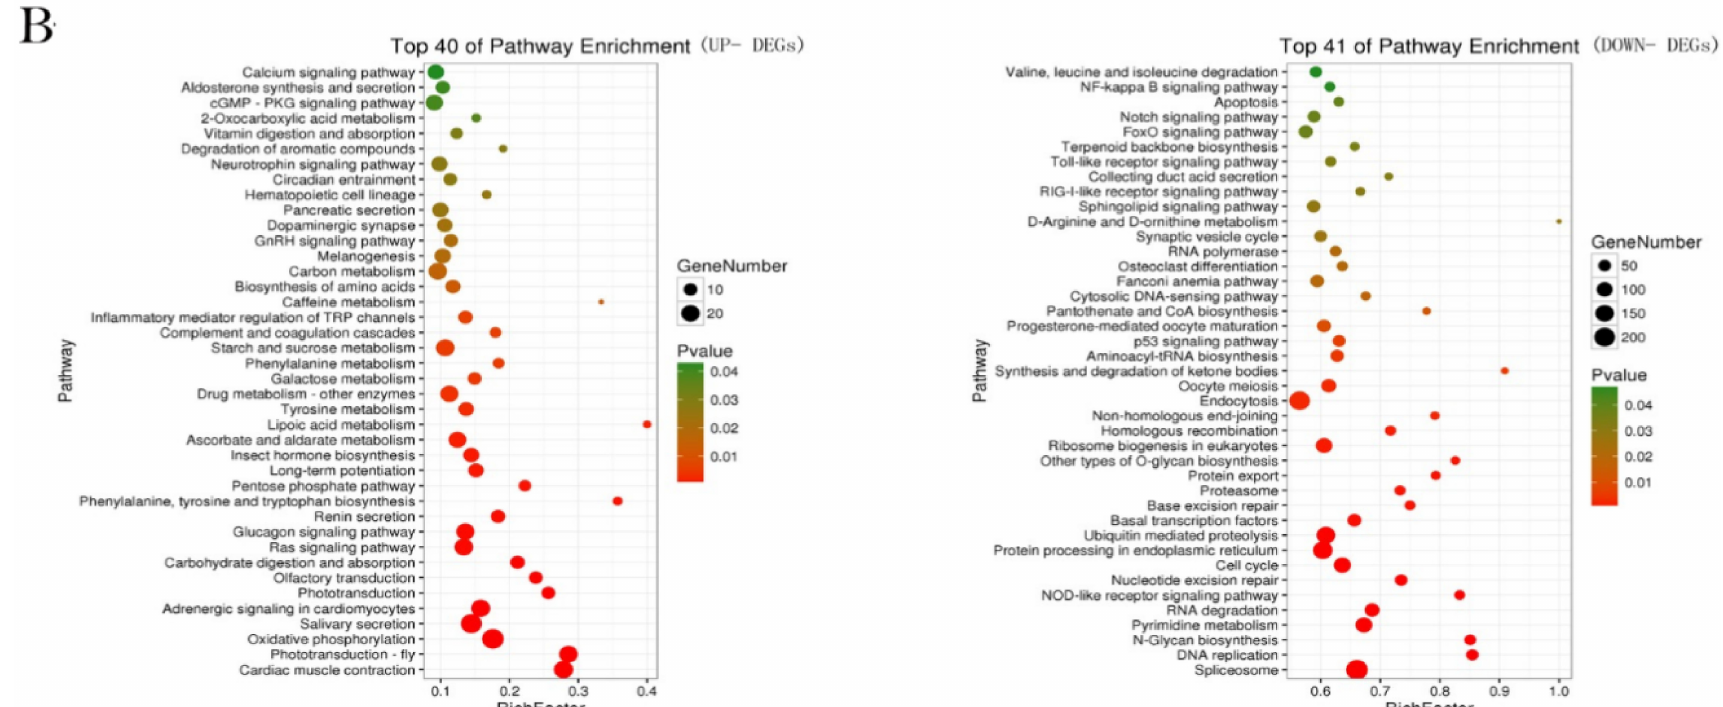
Figure 4. ( A ) Enrichment of metabolic pathways showing lower transcript levels in the larval stage than in the adult stages; ( B ) enrichment of metabolic pathways in female and male adults. The left plot corresponds to genes expressed at higher levels in males than in females and the right plot corresponds to genes expressed at lower levels in males than in